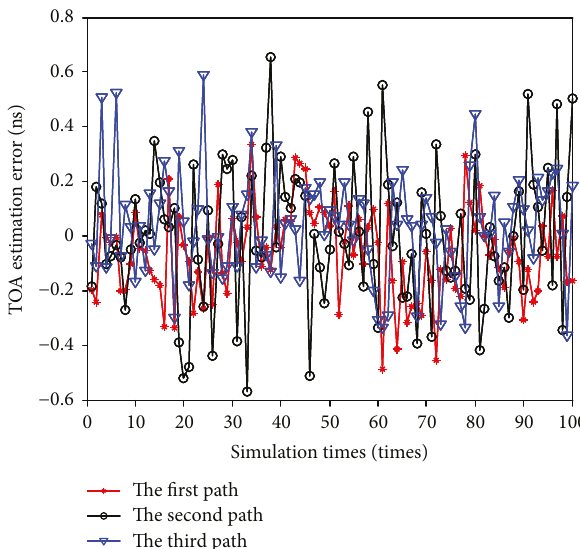
Figure 6: The distribution of TOA estimation error, SNR =5dB.